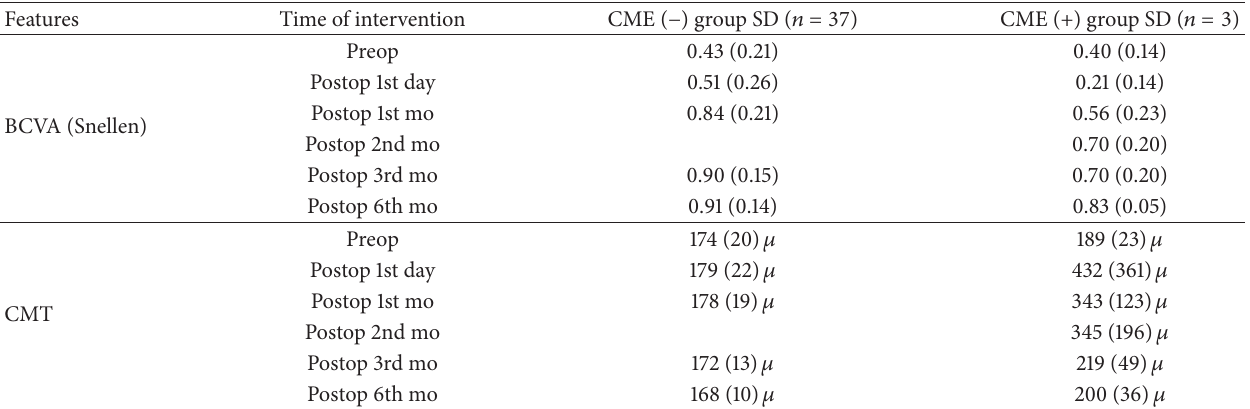
Table 1: The mean preoperative and postoperative best corrected visual acuity and the mean central macular thickness measurements of